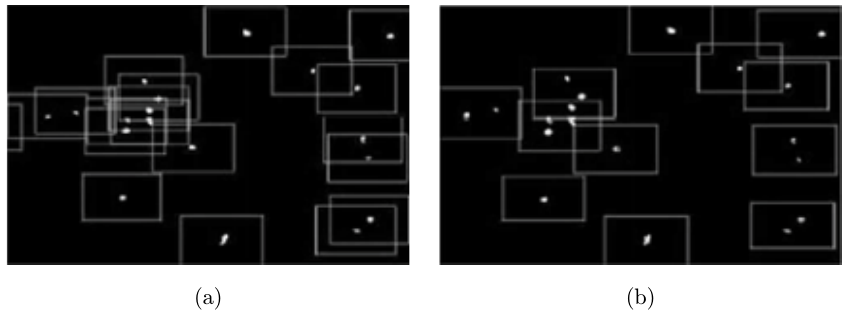
Fig. 4. Comparison of scanning routine before and after clustering. (a) Scanning routine composed of leukocyte nucleus' centroids and (b) Scanning routine composed of clustering